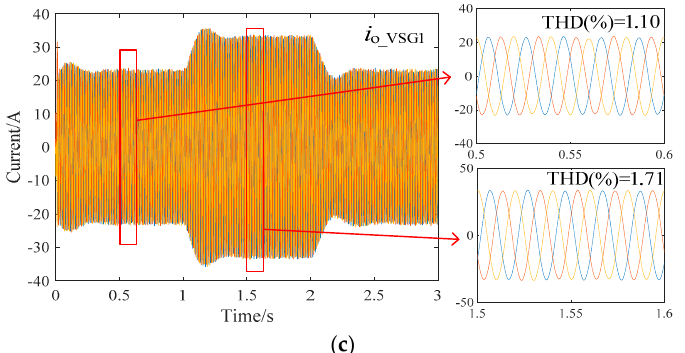
Figure 9. Output waveforms of VSG control to frequency deviation. ( a ) Without decoupling link; ( b ) With decoupling link; ( c ) Output current of VSG1 with decoupling link.